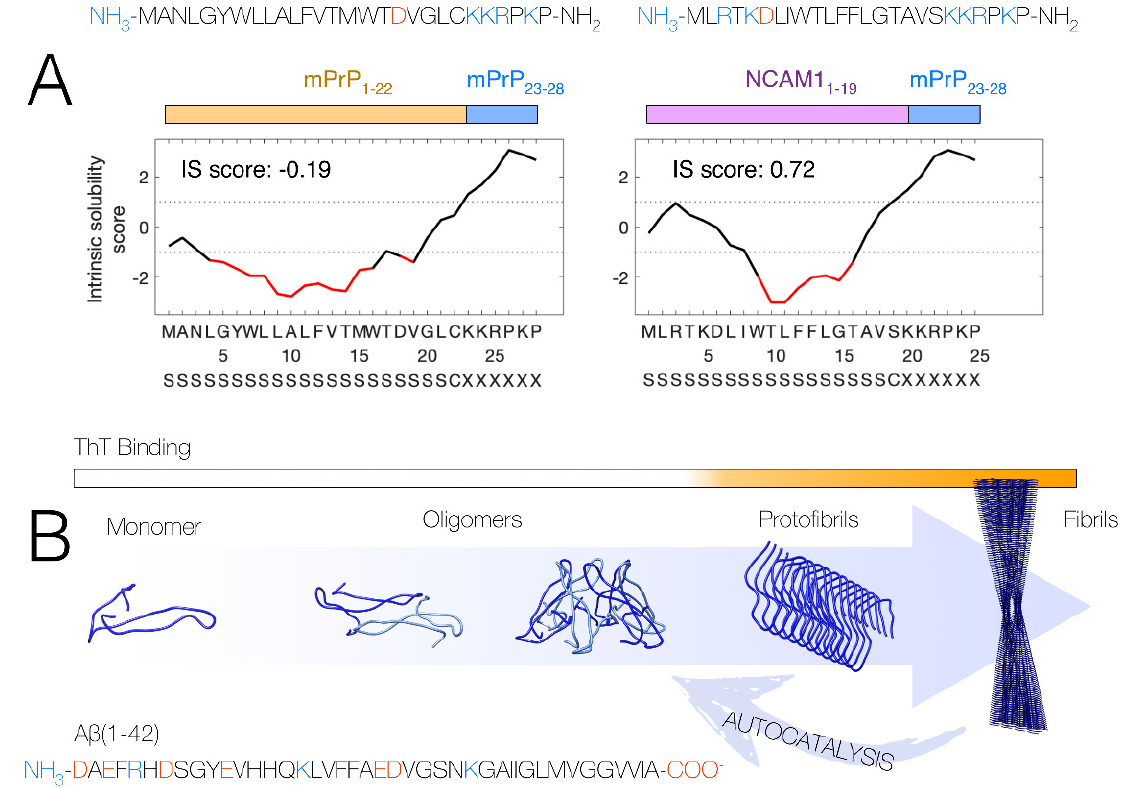
Figure 1. ( A ) Overview of the sequences for mPrP 1–28 and the chimeric NCAM-PrP construct. Positive charges are colored blue, and negative charges are colored red. The intrinsic solubility score according to the CamSol method [5] over the peptide sequences are shown. Poorly soluble regions are shown in red, indicating the higher solubility of NCAM-PrP compared to the original mPrP 1–28 peptide. Eukaryotic signal peptide predictions by the SignalP 5.0 method [6,7] are shown at the bottom, with predicted signal peptide segments marked as “S” and predicted cleavage sites by signal peptidase I marked as “C”. The figure is reprinted/adapted from Król, S. et al. The amyloid- inhibiting NCAM-PrP peptide targets A β peptide aggregation in membrane-mimetic environments.